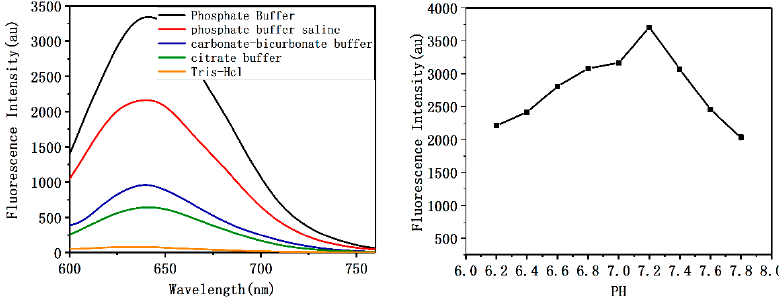
Figure 3. The FI of C6G5C6-apt-AgNCs in buffers at various pH values.